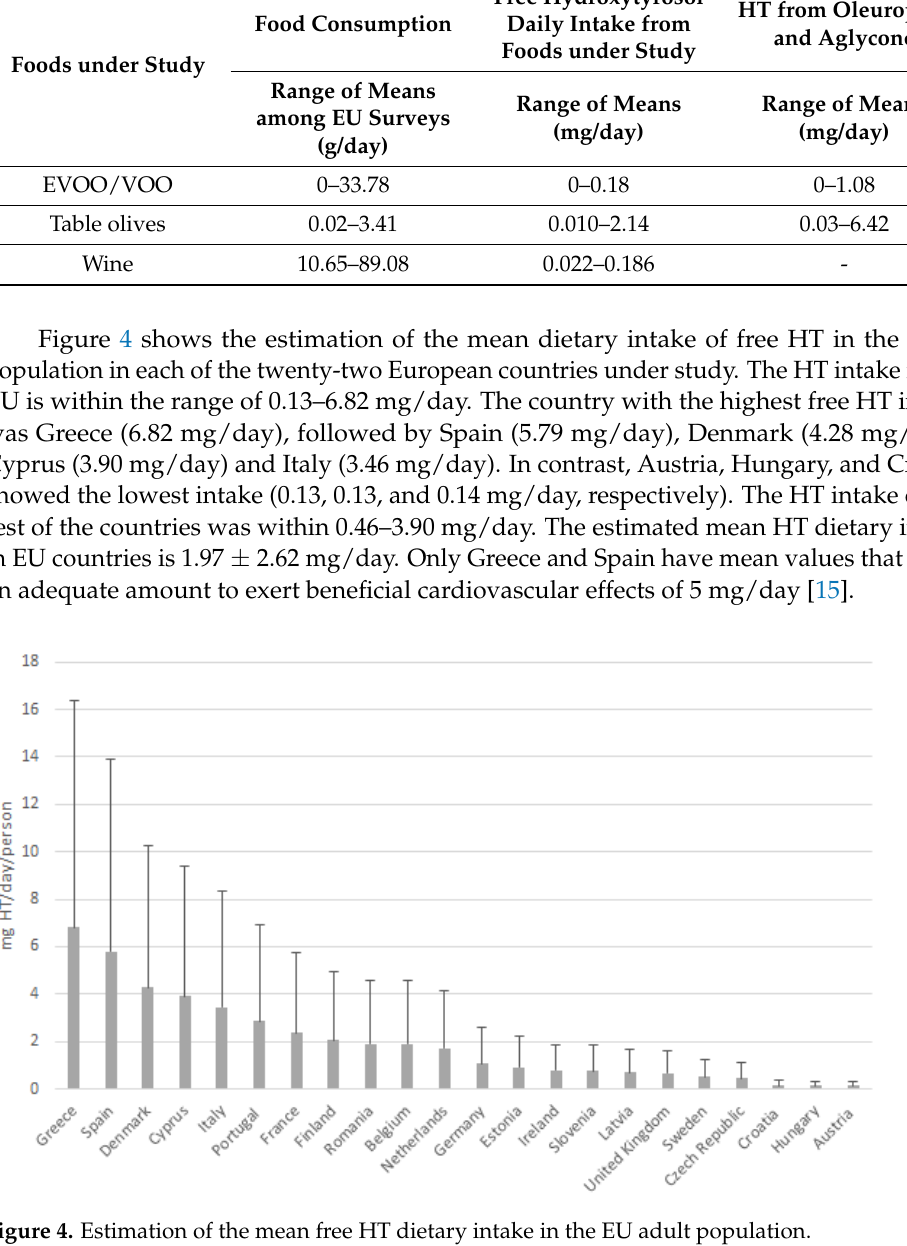
Figure 4. Estimation of the mean free HT dietary intake in the EU adult population.